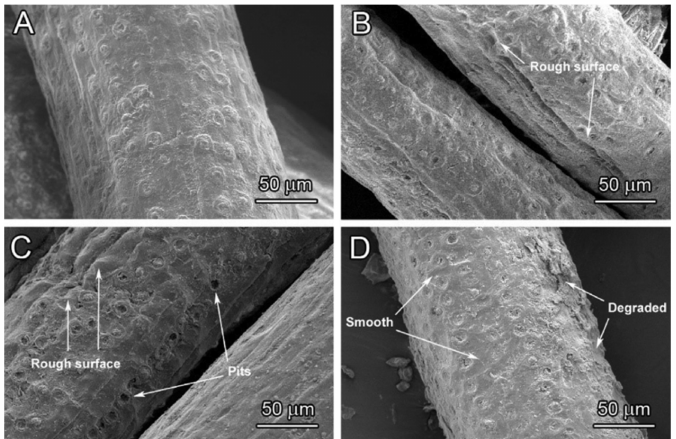
Figure 8. SEM surface analysis of ( a ) raw coir fiber ( b ) 24 h, ( c ) 96 h, and ( d ) 168 h treated coir fibers. Reproduced with permission from [57]. Copyright 2018